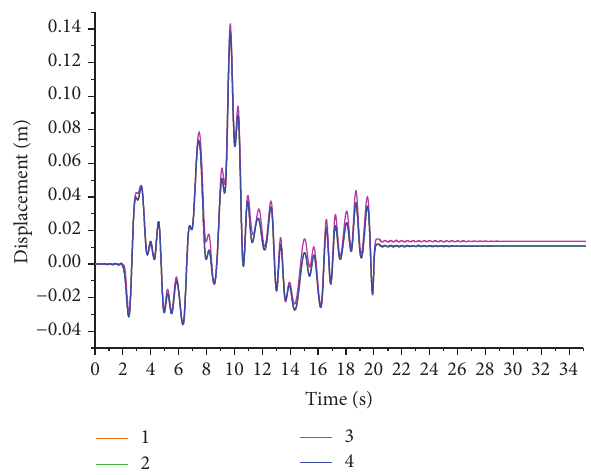
Figure 12: Displacement-time curve of monitoring points without supporting bolts.